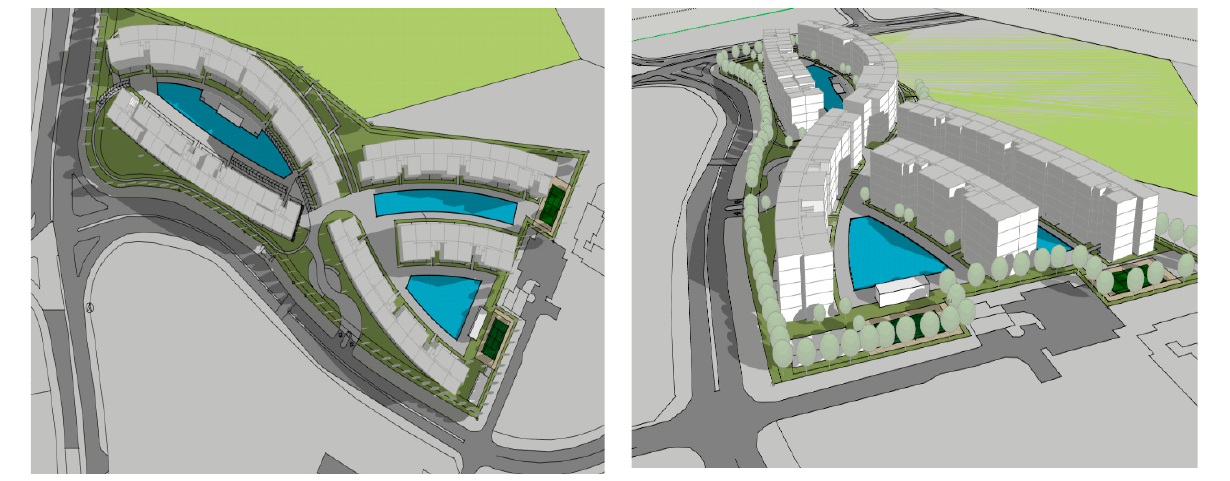
Figure 8. Shadow effect on top and side view [47]. Table 7. Percentage deviation from shaded generation. Table 8. Generation results in shadow